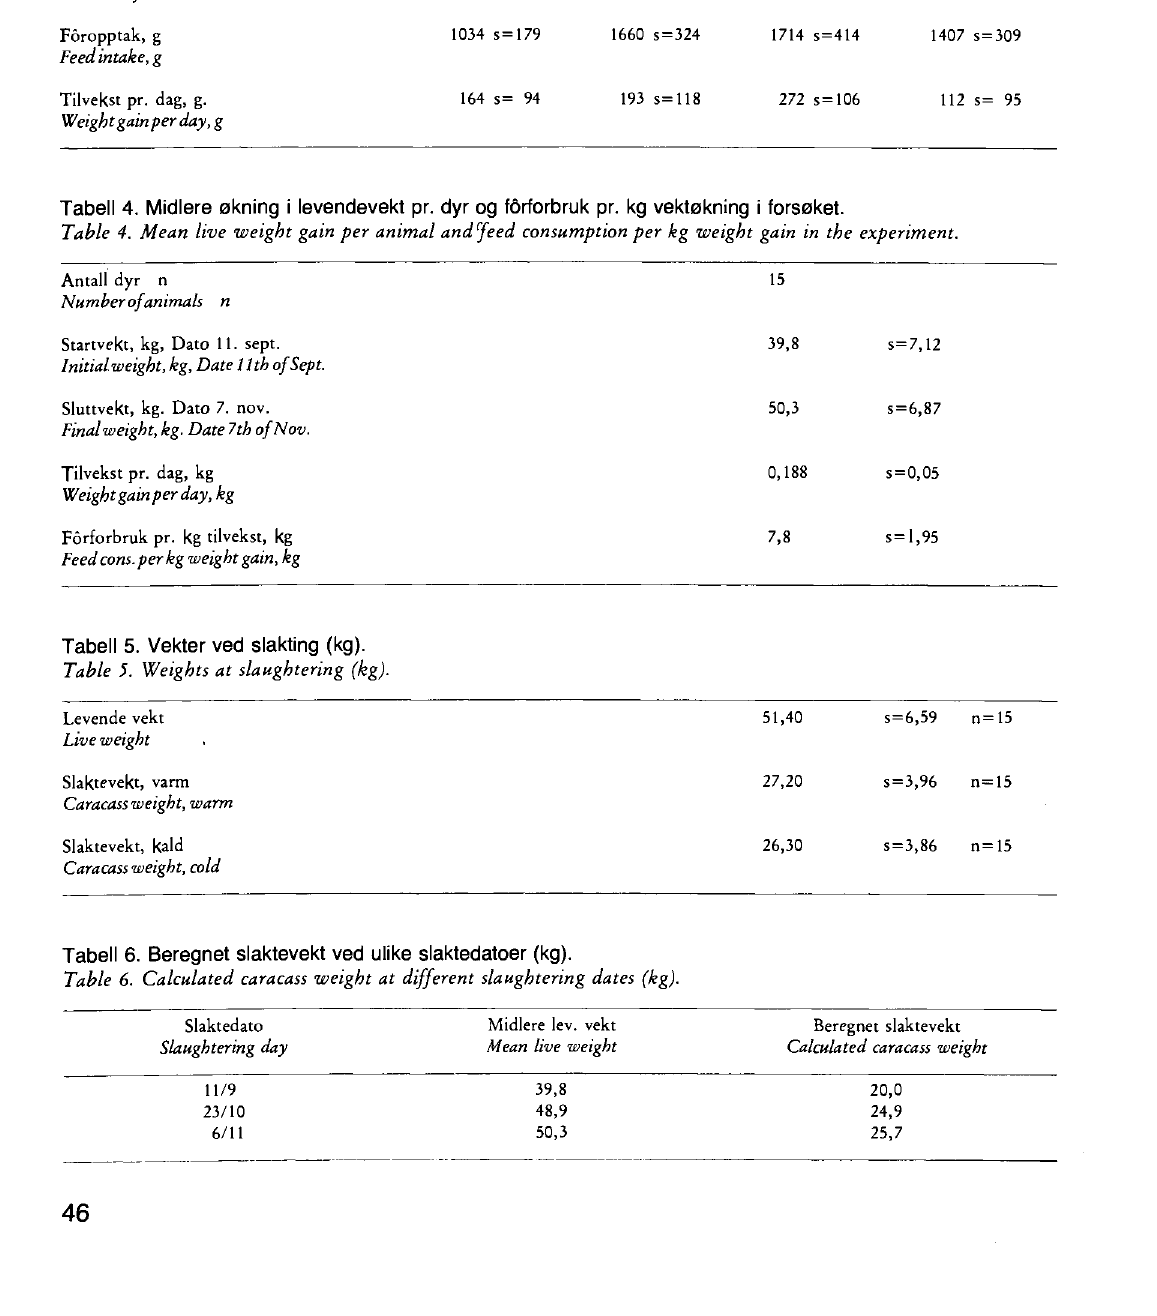
1034 s = 179 164 s= 94 112 s= 95